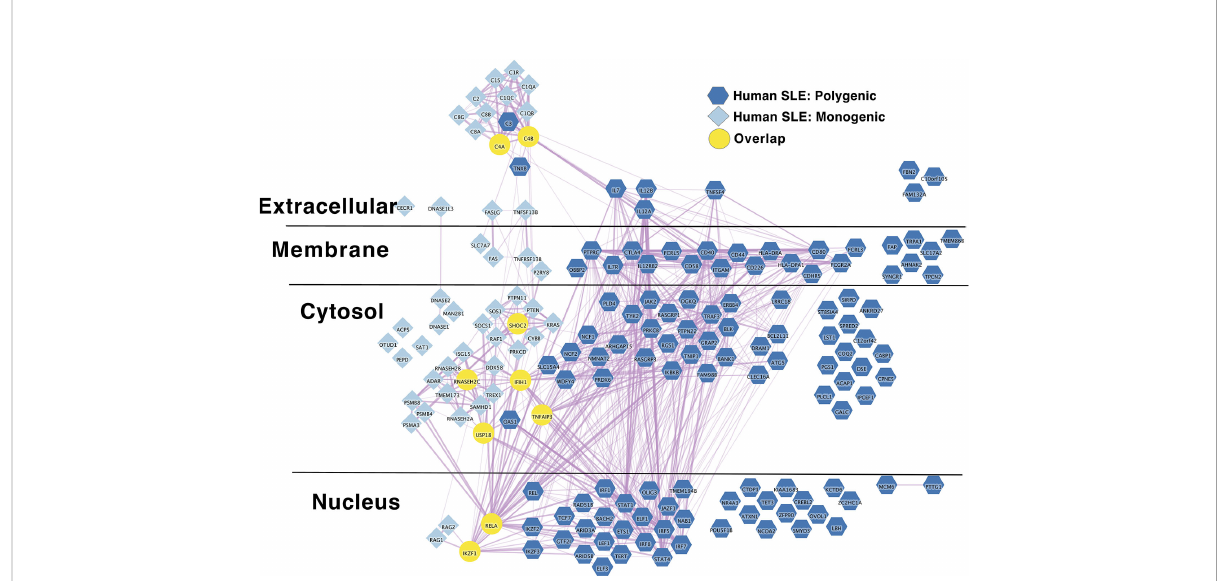
FIGURE 1 Monogenic and Polygenic human SLE risk gene networks overlap at hub genes. Light blue diamond – Monogenic human SLE genes; dark blue hexagon – Polygenic human SLE genes; Yellow circles – overlapping genes. Downloadable/Interactive network diagram can be found at: